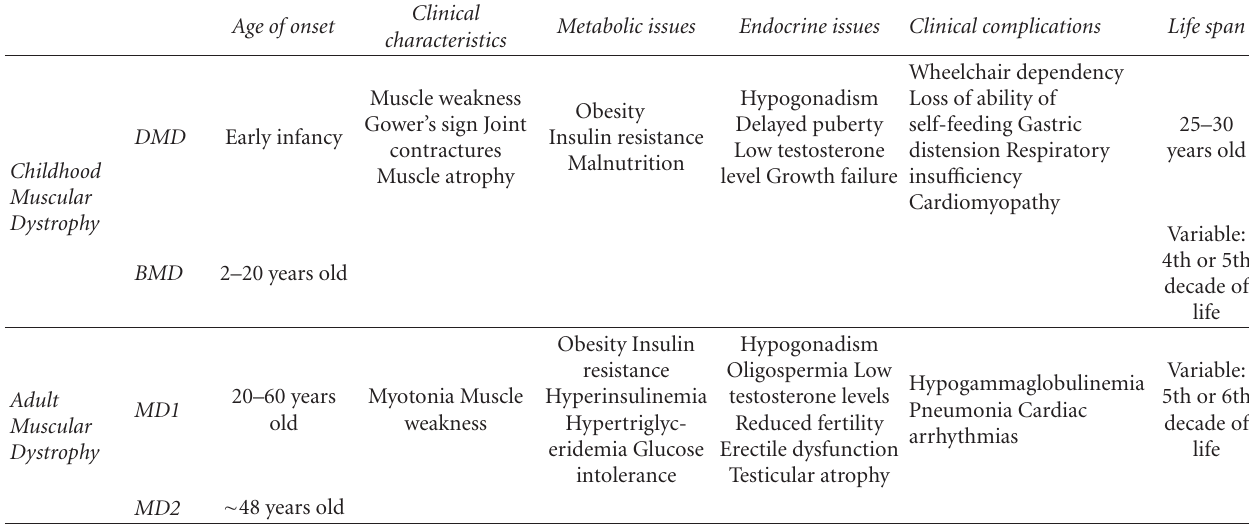
Table 1: Clinical aspects, metabolic and endocrine issues on muscular